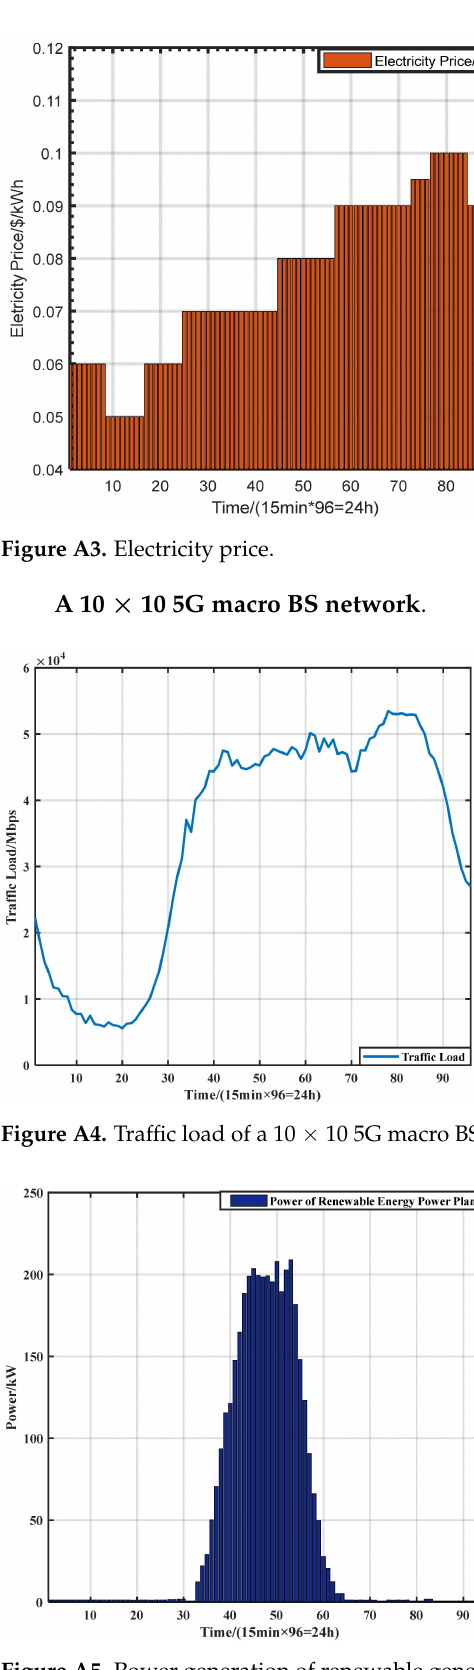
Figure A5. Power generation of renewable generation units of a 10 × 10 5G macro BS